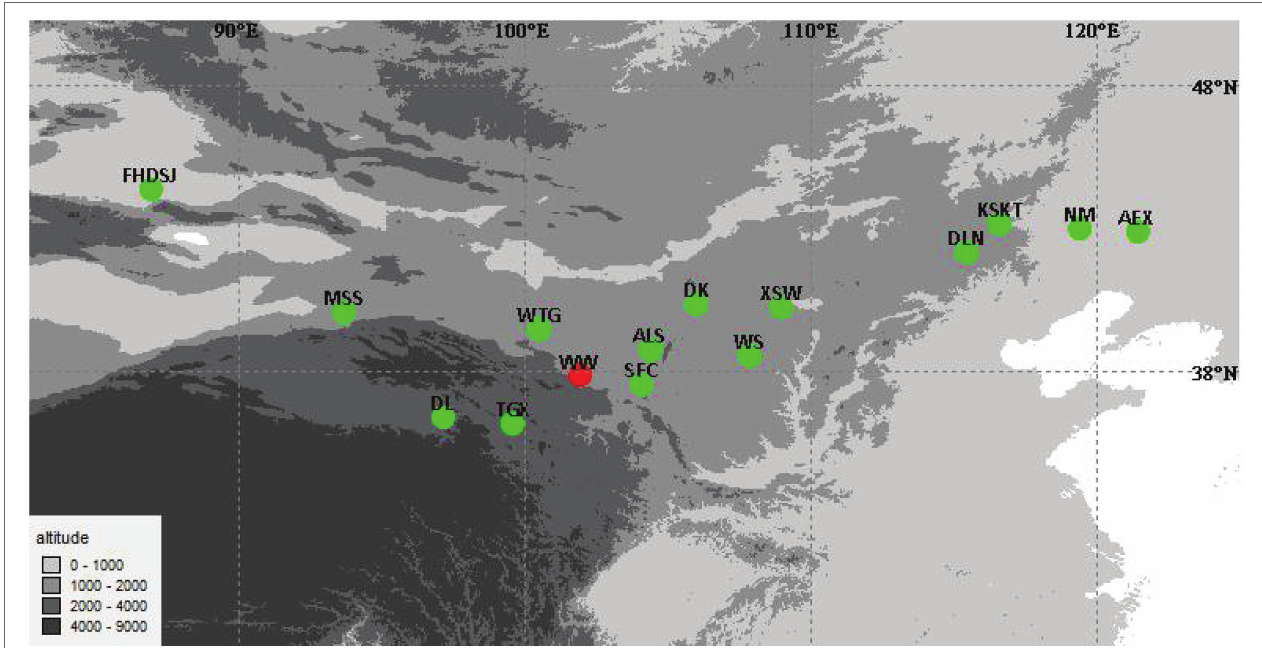
FIGURE 1 | Geographical distribution of 14 Agriophyllum squarrosum populations in China. The red dot indicates the planting place of the common garden